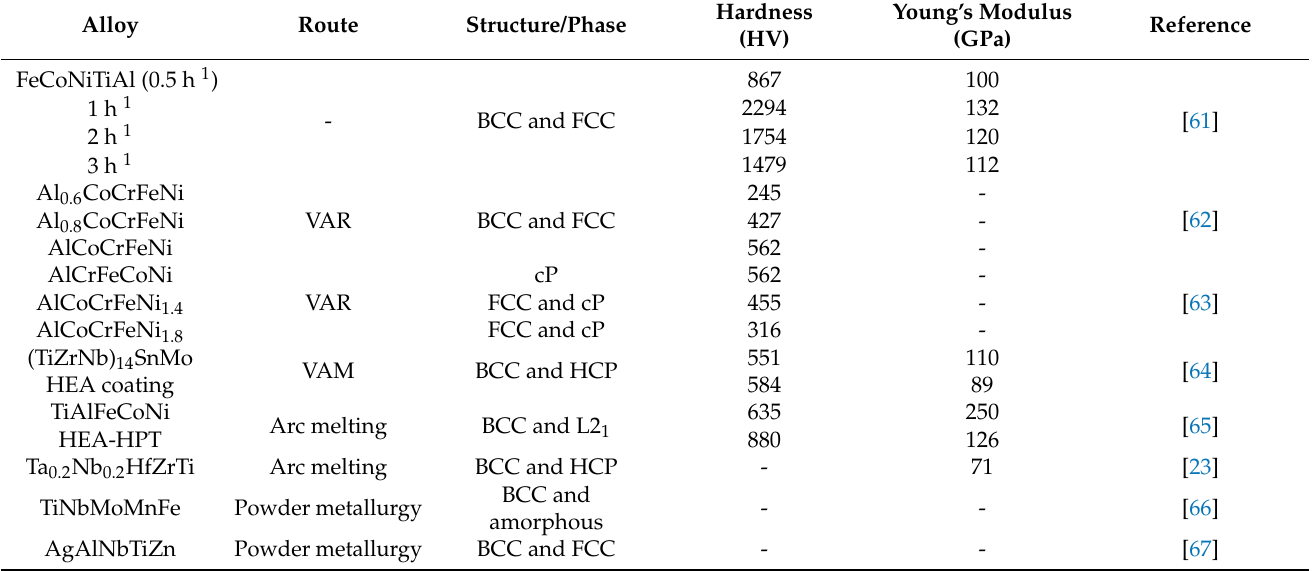
Table 7. Mechanical properties of HEAs for biomedical applications.